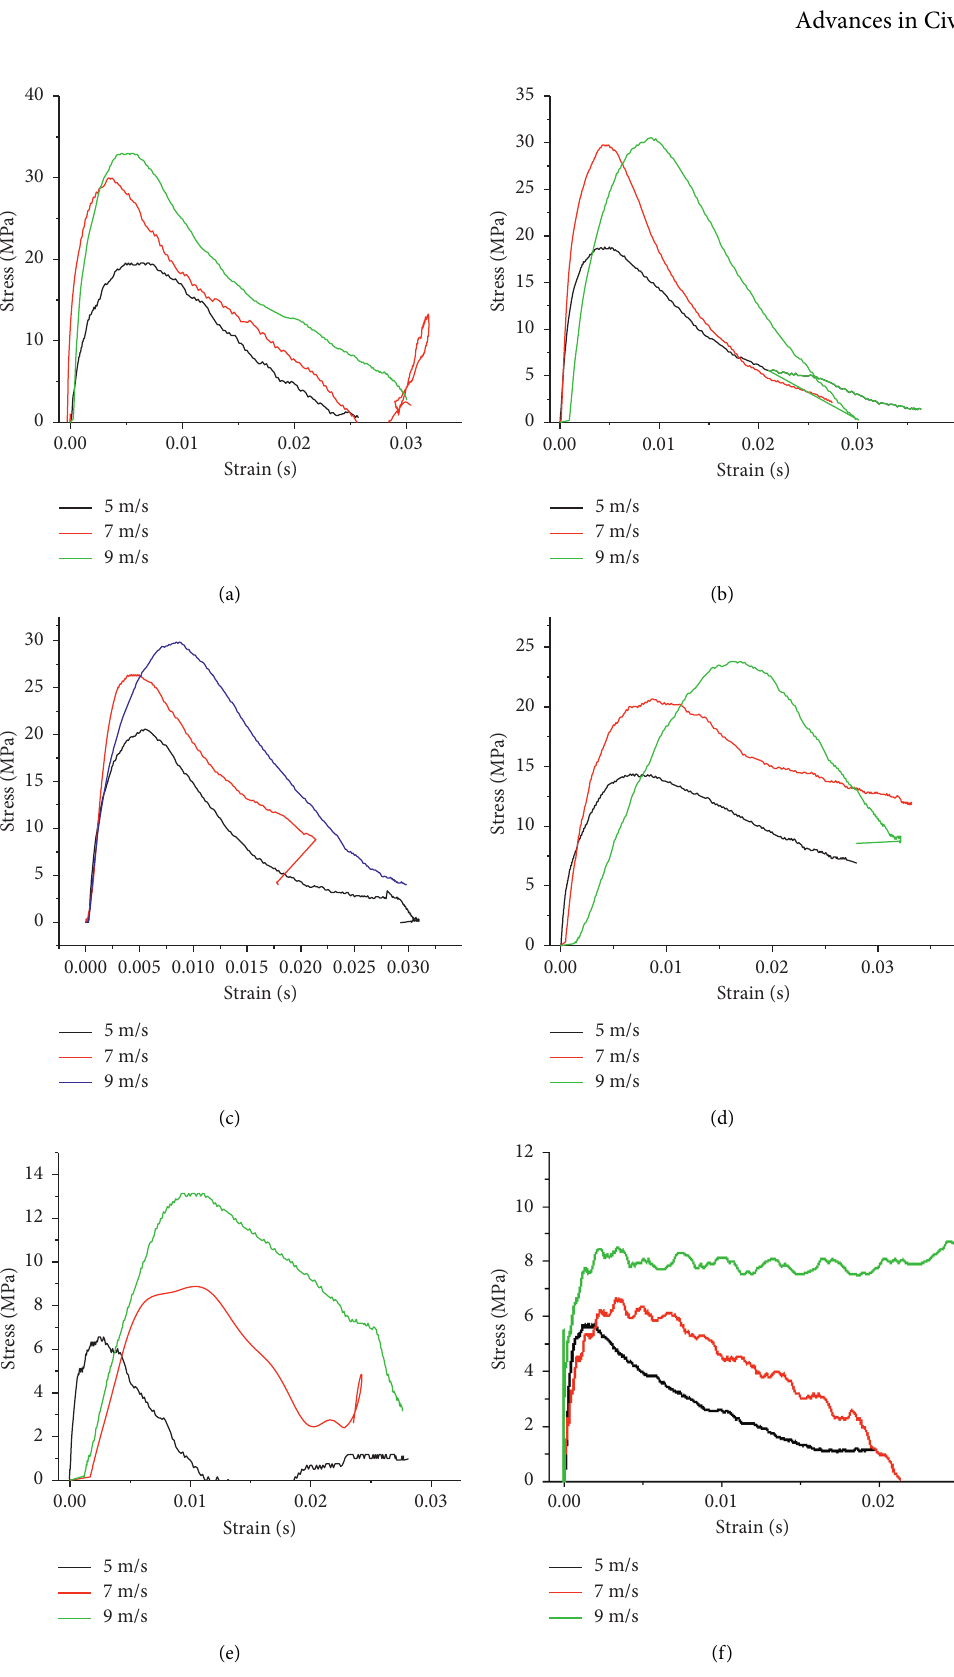
Figure 20: Stress-strain curves for the rock under different dynamic loads and temperature during dynamic BTS tests. (a) 25 ° C. (b) 100 ° C. (c) 200 ° C. (d) 400 ° C. (e) 600 ° C. (f) 800 °